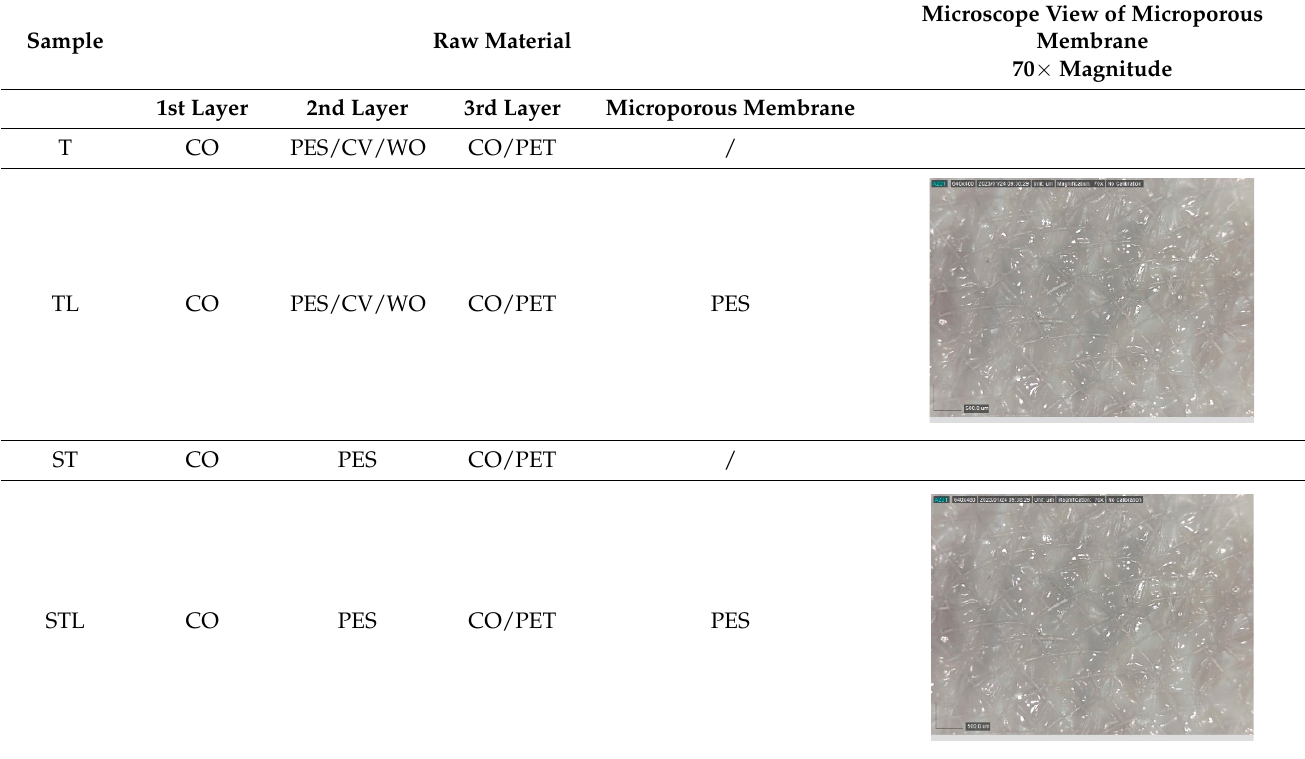
Table 1. Raw material composition of analyzed samples.